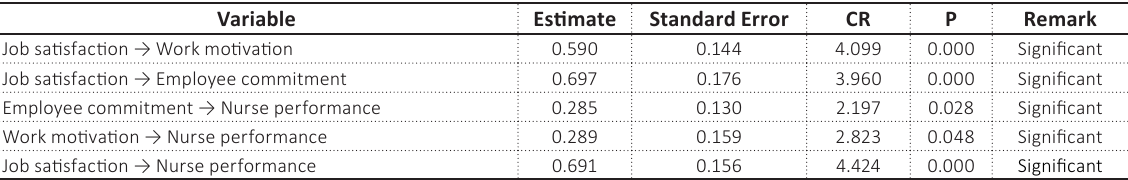
Table 1. Results of path